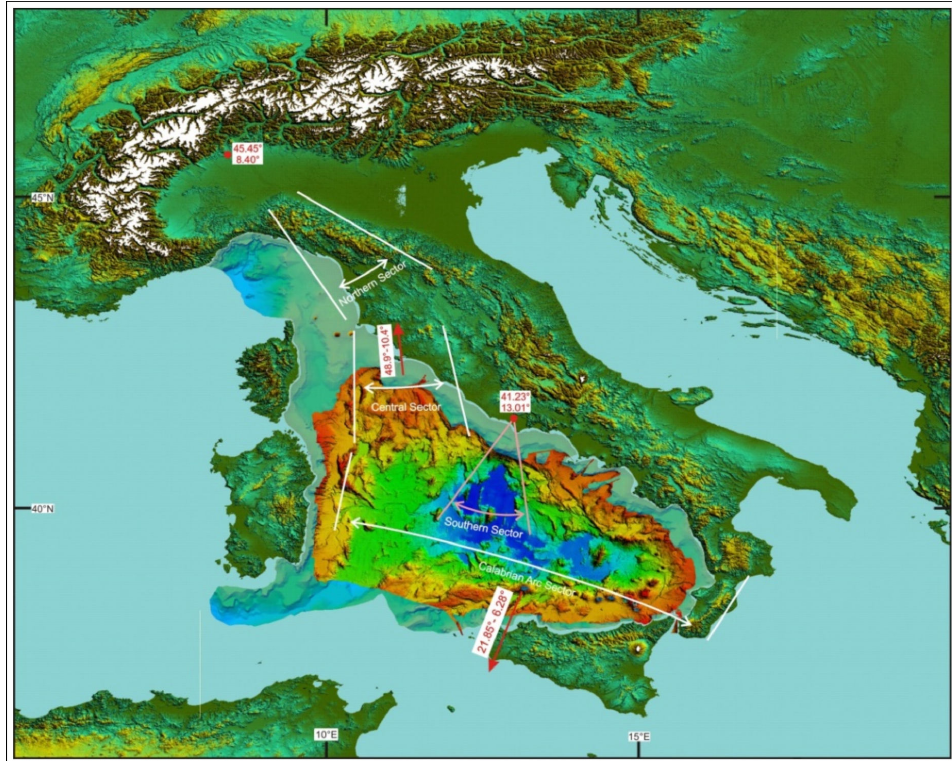
Figure 18. Morpho-tectonic map and multibeam bathymetry of the Tyrrhenian–Apennine system, showing extension directions in the Tyrrhenian Basin. ( White and pink lines ) show extension started respectively 19 Ma and 7 Ma. ( Red points ) are Euler poles. ( Red arrows ) indicate the Euler poles out of the figure, coordinates of these poles are shown. Real angle of rotation is shown for each pole. Modified after [27]. The multibeam bathymetry is after